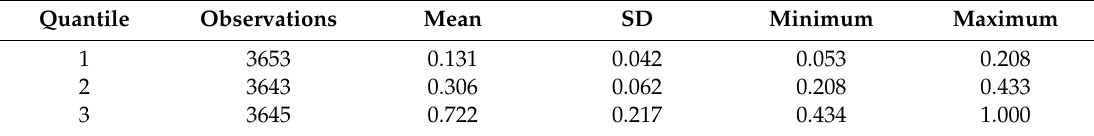
Table 2. Classification of firm-year observations based on Herfindahl–Hirschman index (HHI). Quantile Observations Mean SD Minimum Maximum 1 3653 0.131 0.042 0.053 0.208 2 3643 0.306 0.062 0.208 0.433 3645